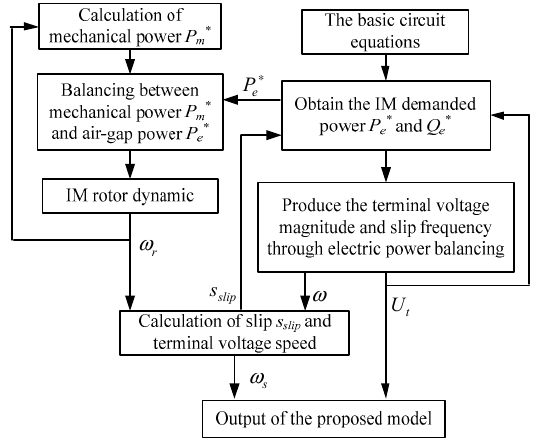
Figure 3. The block diagram of proposed method for IM modeling.